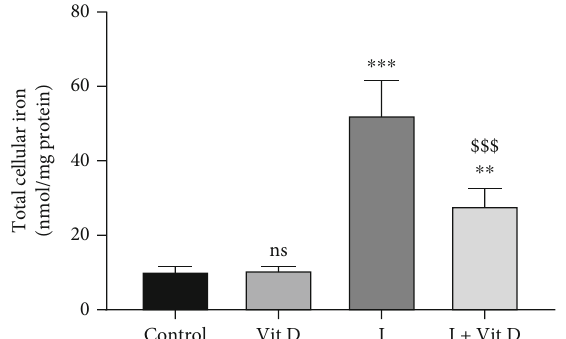
Figure 3: Relative concentrations of total cellular iron determined by atomic absorption spectroscopy in Vero cells treated with iohexol at a concentration of 100mg iodine/mL or pretreated with 1 μ M vitamin D3. Results are represented as mean ± SD . One-way ANOVA and Tukey posttest ( n = 4 ) were used to analyse the results. ns: not signi fi cant; p < 0 : 05 , ∗∗ p < 0 : 01 , and ∗∗∗ p < 0 : 001 (2-tailed) in comparison with the control; $ p < 0 : 05 , $$ p < 0 : 01 , and $$$ p < 0 : 001 (2-tailed) iohexol (I) versus iohexol+vitamin D (I +Vit D)